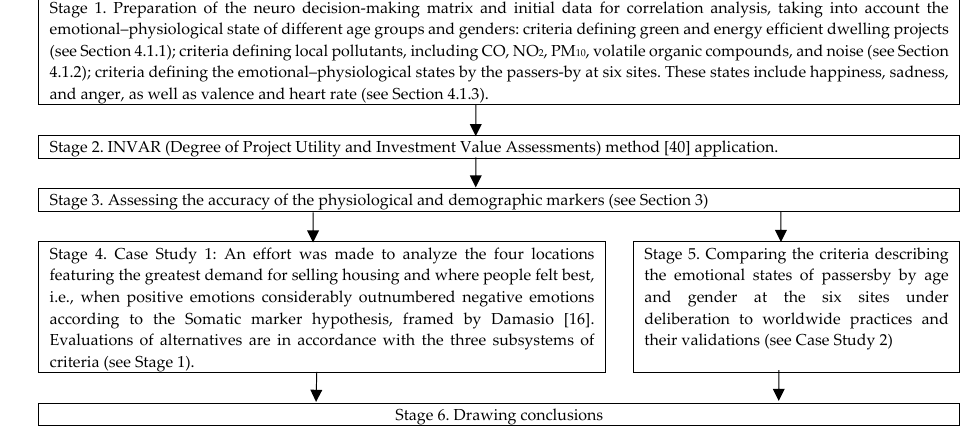
Figure 1. General layout of the multisensory, green, and energy efficient housing neuromarketing method. General layout of the multisensory, green, and energy e ffi cient housing neuromarketing The same research methods listed above were applied to all the depersonalized segments of the